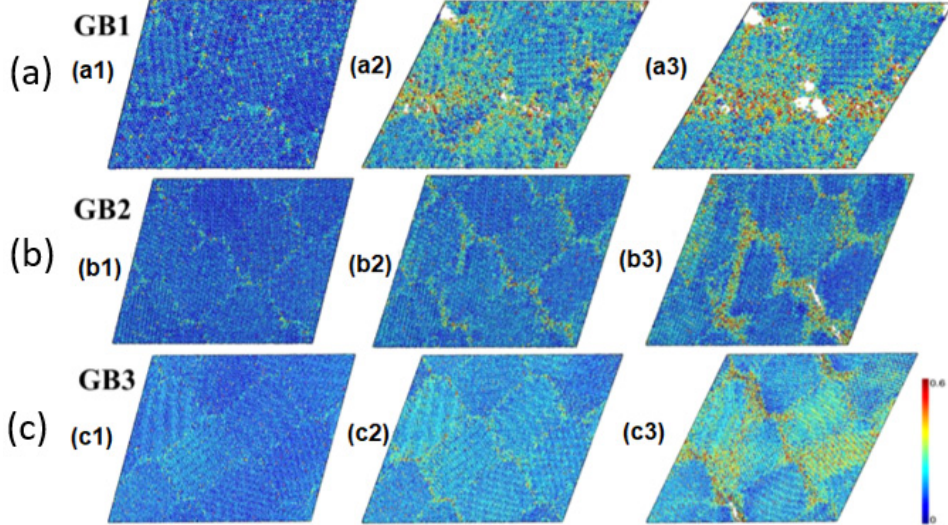
Figure 10. ( a – c ) Snapshots of three n-B 4 C GB models at different time intervals, showing ( a1 – c1 ) initiation of plastic deformation, ( a2 – c2 ) termination of plastic deformation, and ( a3 – c3 ) formation of cavities. Strain from 0.0 to 0.6 is represented by the colored bar code. Reproduced with permission from [76]. Copyright 2022